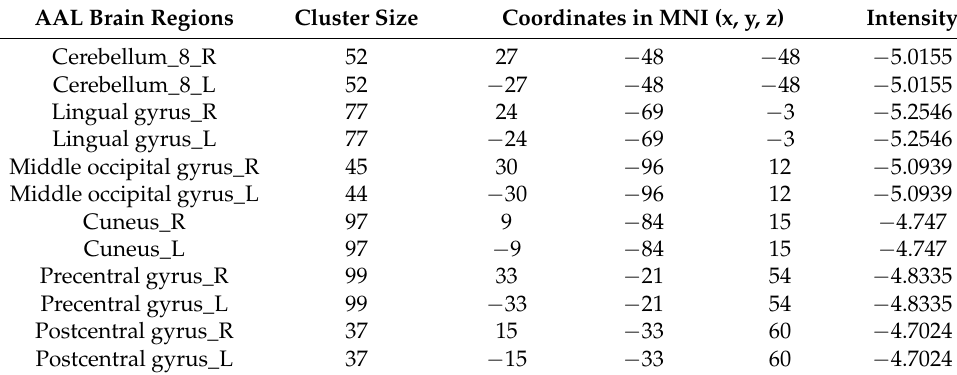
Table 2. Alterations in VMHC between MwoA patients and HCs.